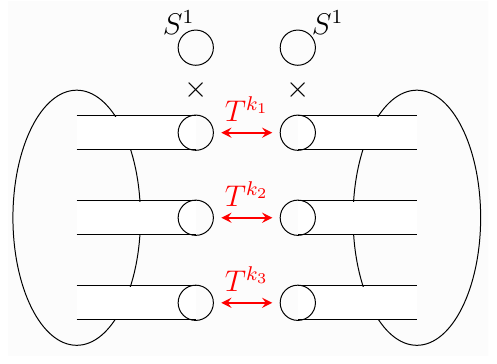
Figure 10 . A geometry generating the theory given in figure